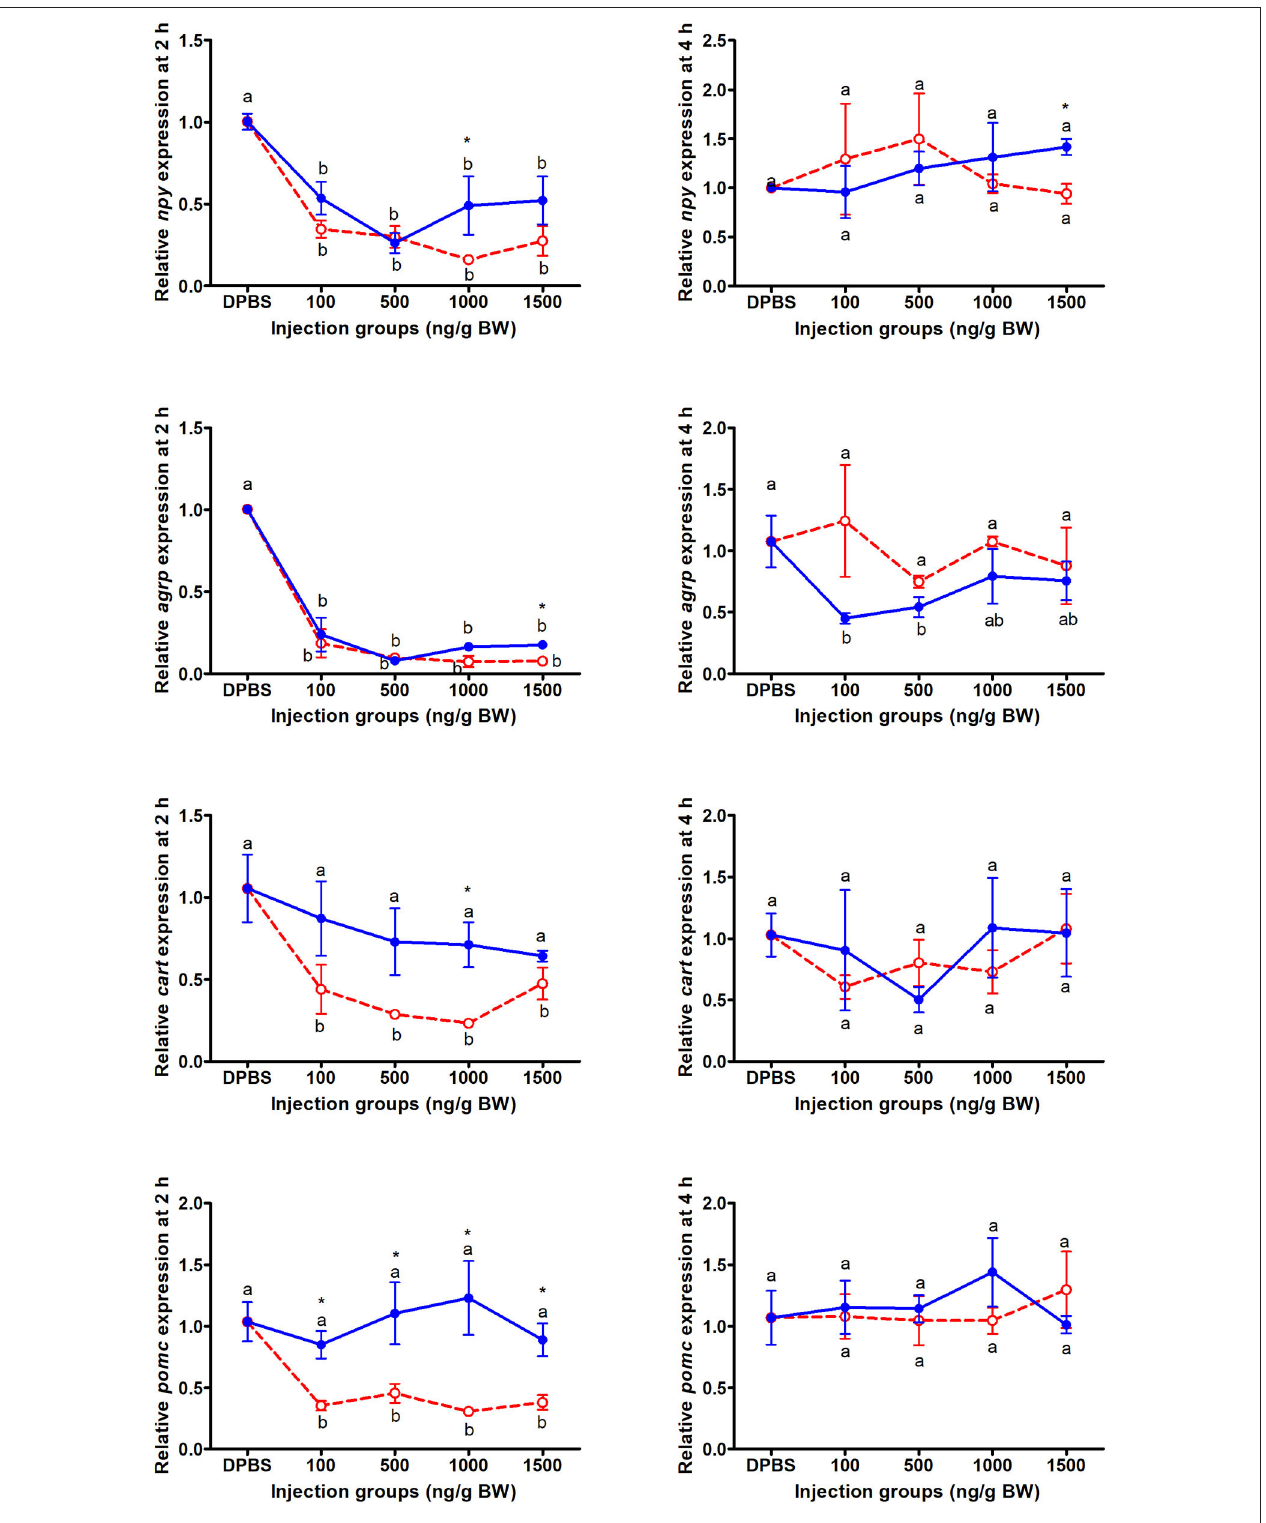
FIGURE 2 | The expressions of appetite genes after acute LepA (red dotted line) and LepB (blue solid line) administration. Data represent means ± S.E.M ( n = 4). Significance level are marked with different letters ( P < 0.05), compared with the values from DPBS injected mandarin fish. Mean values with an asterisk (*) above show significant differences between fish groups injected with leptin A and leptin B at the same dose ( P < 0.05).